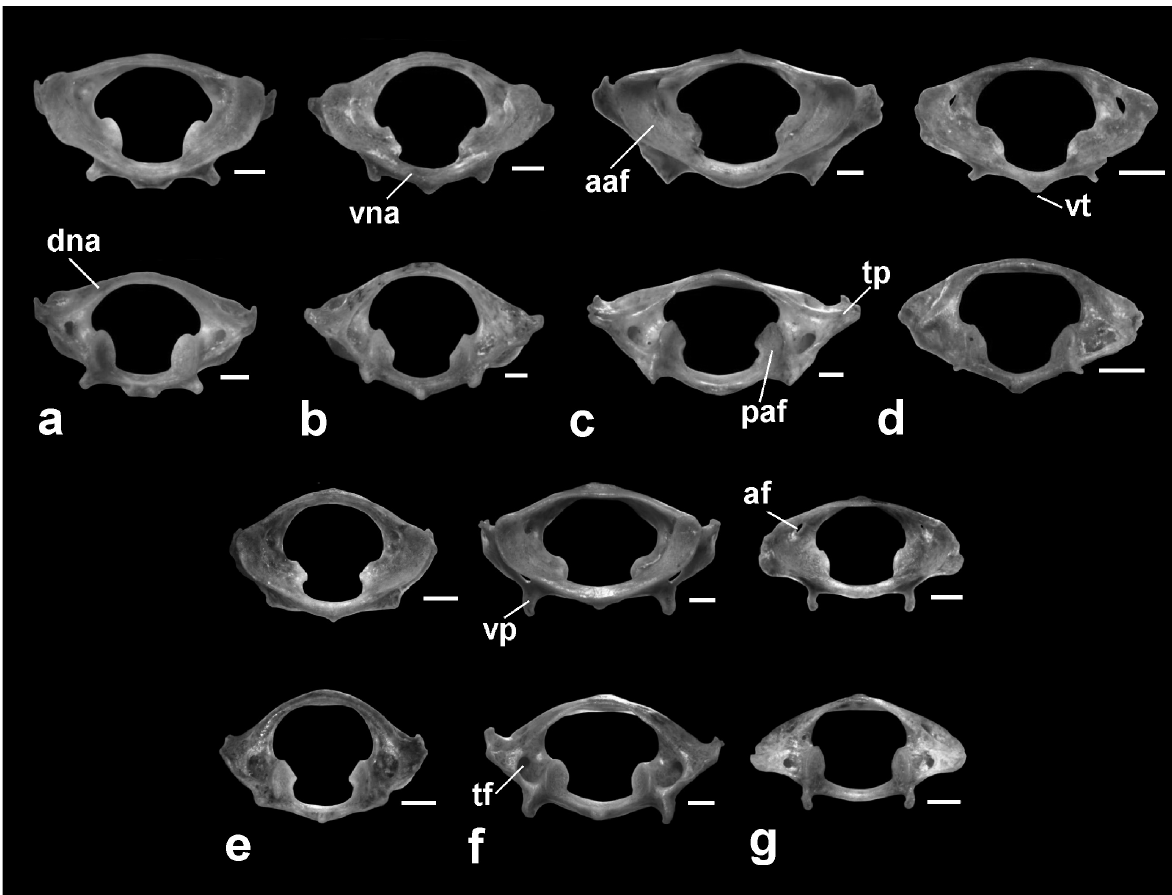
Figure 2 - Anterior (top) and posterior (bottom) views of atlas: a . Desmodus rotundus ; b . Diaemus youngi ; c . Chrotopterus auritus ; d . Micronycteris microtis ; e . Sturnira erythromos ; f . Artibeus planirostris ; g . Anoura caudifer . Acronyms: aaf: anterior articular fovea; af: atlantal foramen; dna: dorsal neural arch; paf: posterior articular fovea; tf: transverse foramen; tp: transverse process; vna: ventral neural arch; vp: ventral process; vt: ventral tubercle. Scale bar represents 1 mm.